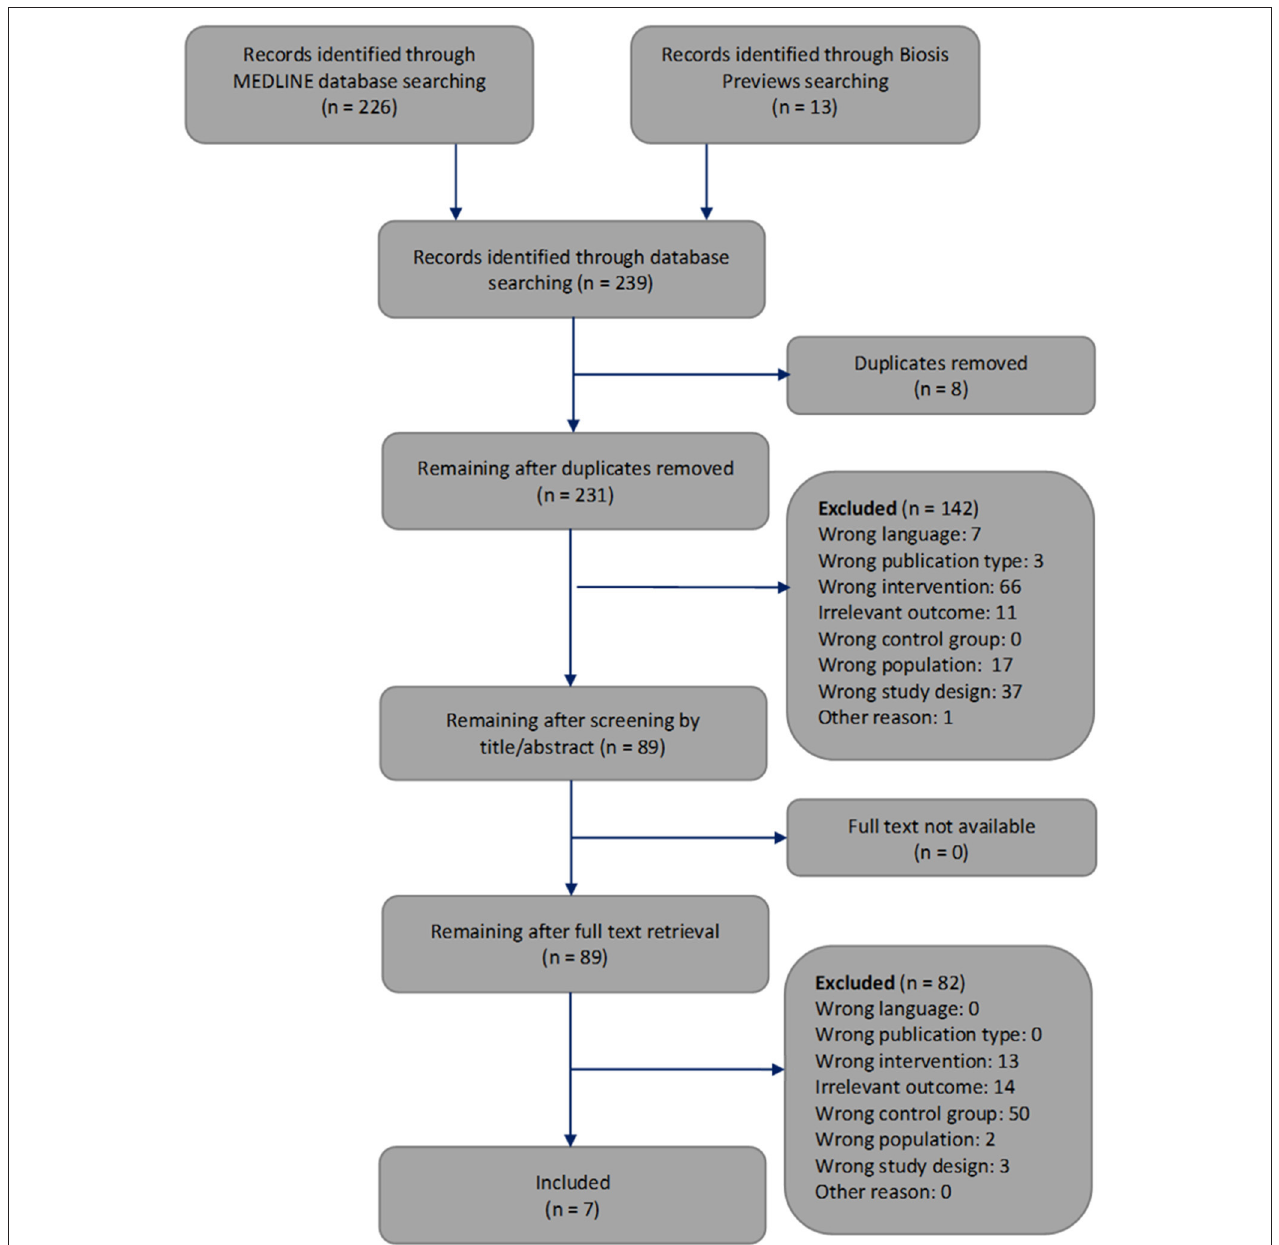
FIGURE 3 | Flowchart through different phases of the systematic review modified according to Moher’s publication (Moher et al., 2009).